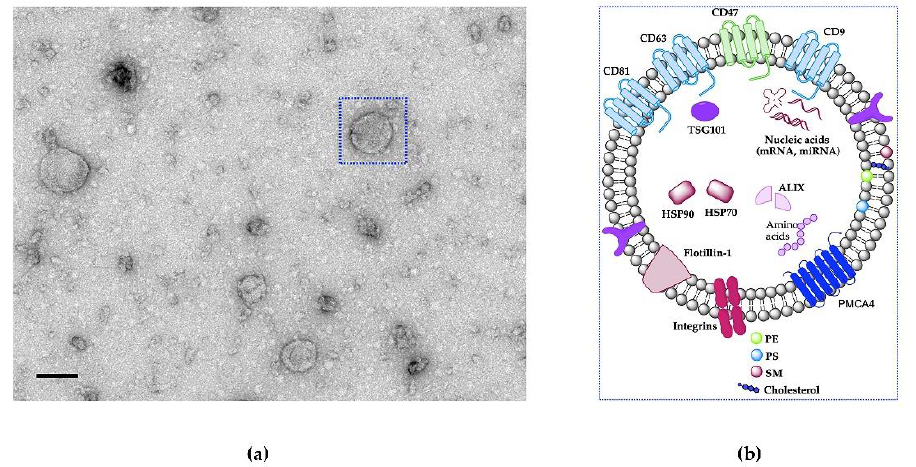
Figure 1. Natural EVs morphology. ( a ) TEM image of natural EVs (oviductosome, OVS) isolated from mouse oviductal fluid of ~100 nm in size. Scale bar represents 100 nm. ( b ) Schematic showing the structural components and cargo of extracellular vesicles which packed with a variety of cellular components, including various transmembrane proteins (tetraspanins, PMCA4), heat shock pro- teins, adhesion proteins, nucleic acids (mRNAs and miRNAs), and lipids (PE, PS, SM, and choles- terol). EVs also protect encapsulated cargo from clearance by macrophages via CD47 (“do not eat me” signal).